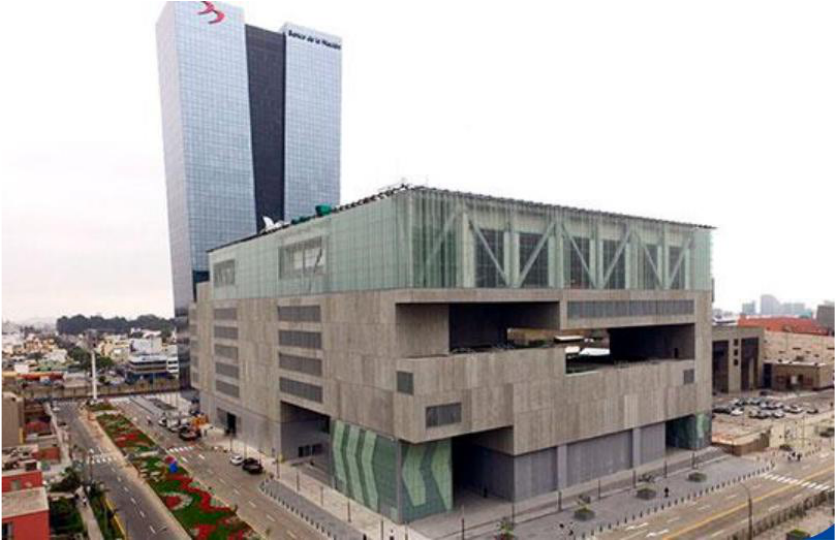
Figure 6. Lima Convention Center. Resource: https://www.lima2019.pe/sedes/centro-de-conven- ciones-lima (accessed on 5 November